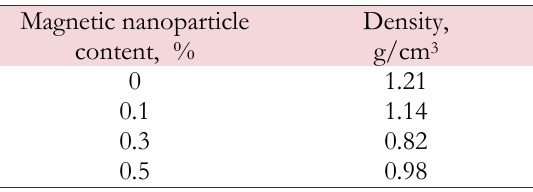
Table 3: Density of magnetic composite in dependence on the amount of the